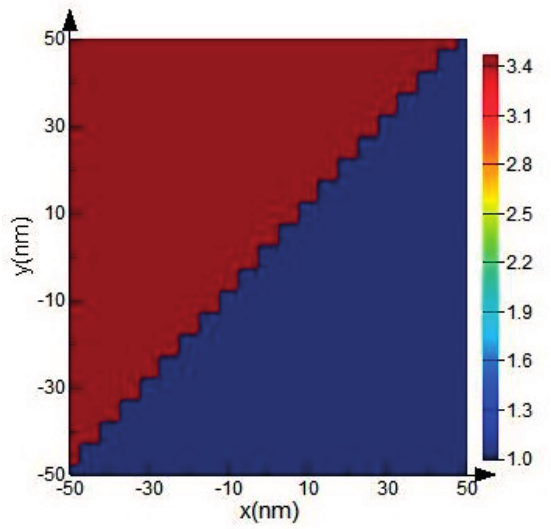
Figure 9. The local meshing in the 2D-FDTD simulation at the interface between air-trench and the bending waveguide. The mesh grid is 5 nm.